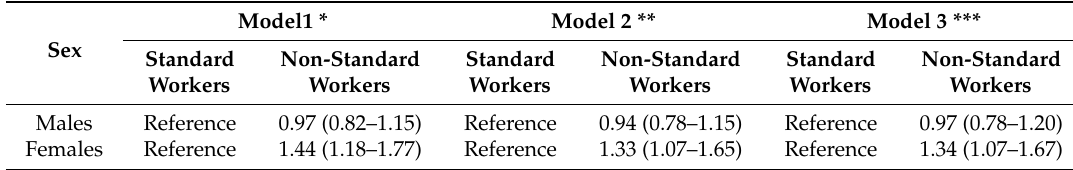
Table 3. Prevalence odds ratios of factors affecting metabolic